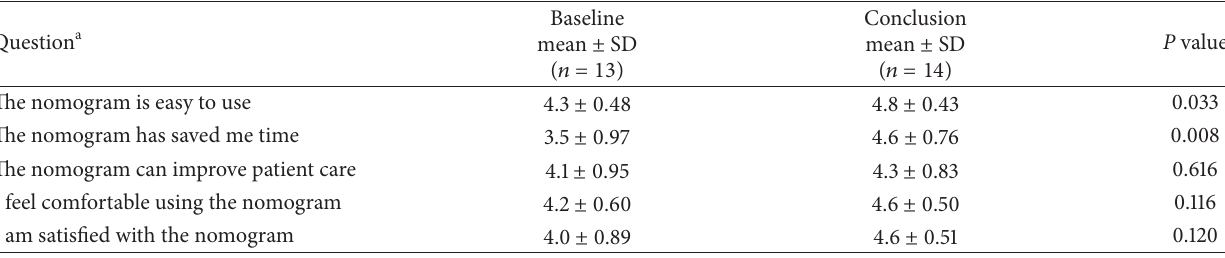
Table 3: Pharmacist survey evaluating opinions of